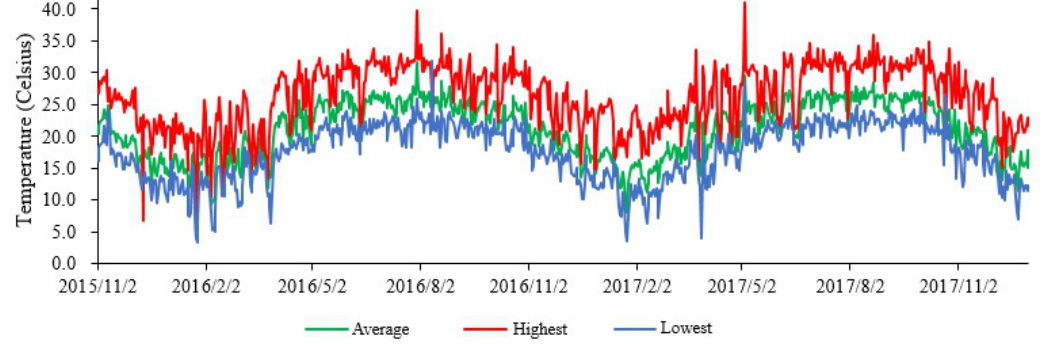
Figure 3. Temperature data for Huisun Forest Park (2015/11/2–2017/12/31). Tourist Season